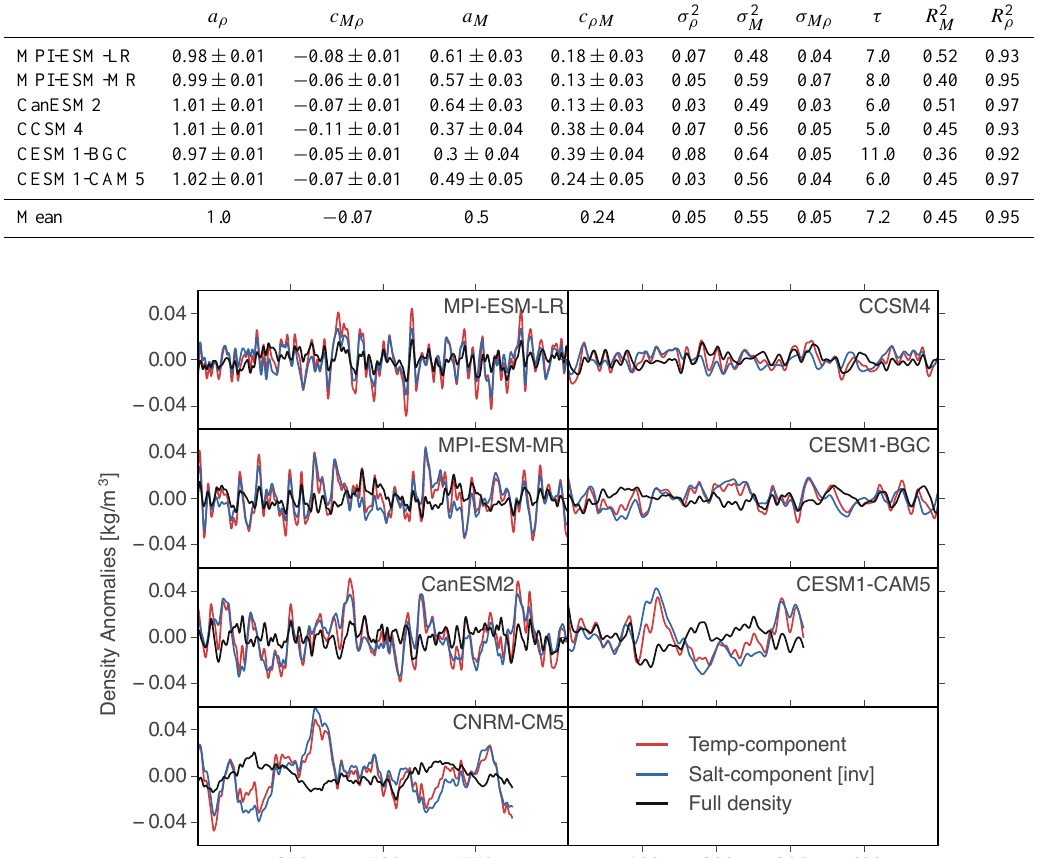
Table 4. Results of the multivariate regression of the conceptual coupled AMOC–NADO density system as in Eq. (4) to the individual models. Fig. 6. Resulting time series graphs for AMOC, GMT and SIE by applying a method introduced in Runge et al. (2012b). Based on the sign of the partial correlation as a result of the graph estimation algorithm, we denote positive (negative) partial correlations in red (blue). Direct links are indicated by curved lines with the associated time lags. Straight lines represent contemporaneous links at lag zero.